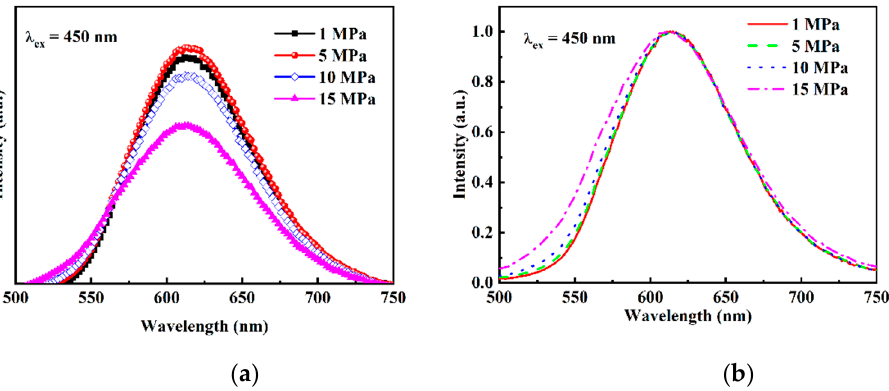
Figure 5. Emission ( a ) and normalized emission spectra ( b ) spectra of Sr 2 Si 5 N 8 : Eu 2+ phosphors prepared at different pellet pressure